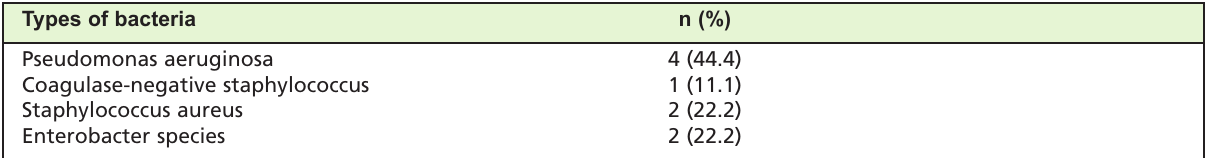
Table VI: Types of organisms obtained from culture and sensitivity Types of